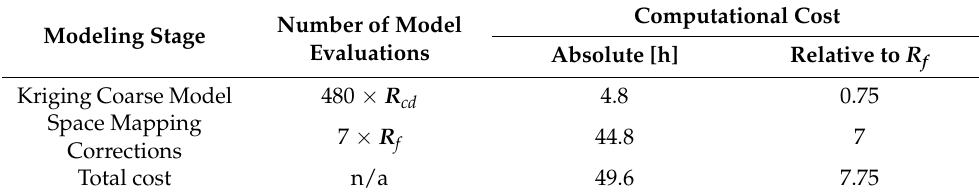
Table 2. On-chip inductor surrogate model setup